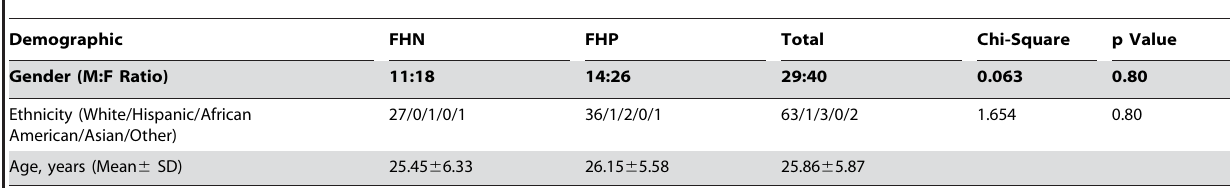
Table 1. Subject